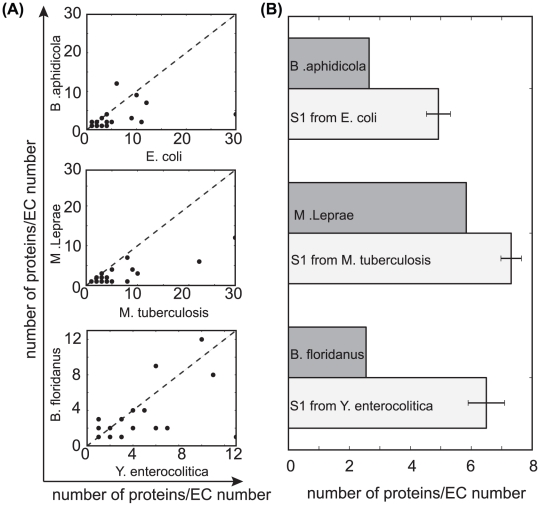
Reduction in enzymatic redundancy.(A) Number of proteins per E.C number in closely related organisms, defined at the most functionally specific level (fourth E.C. digit). Species are the same as in Figure 5. Note that Reduced genomes systematically code for less proteins of each E.C number, indicating loss of genetic redundancy in enzyme functions (B) the number of proteins per E.C. number is smaller in Reduced genomes than could be expected under a neutral scenario of gene loss (simulated according to S1), where the starting genome is that of the closest Free living organism indicated.